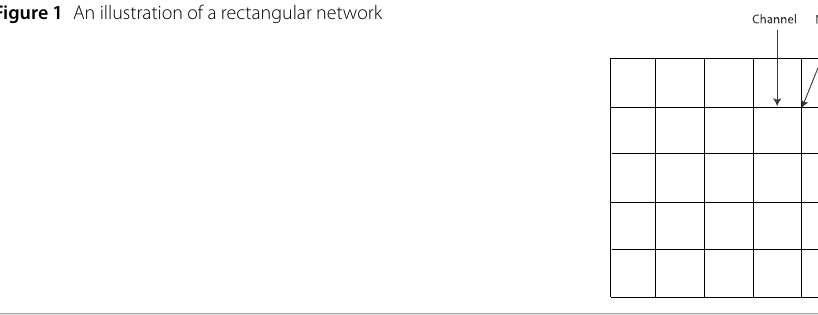
Figure 1 An illustration of a rectangular